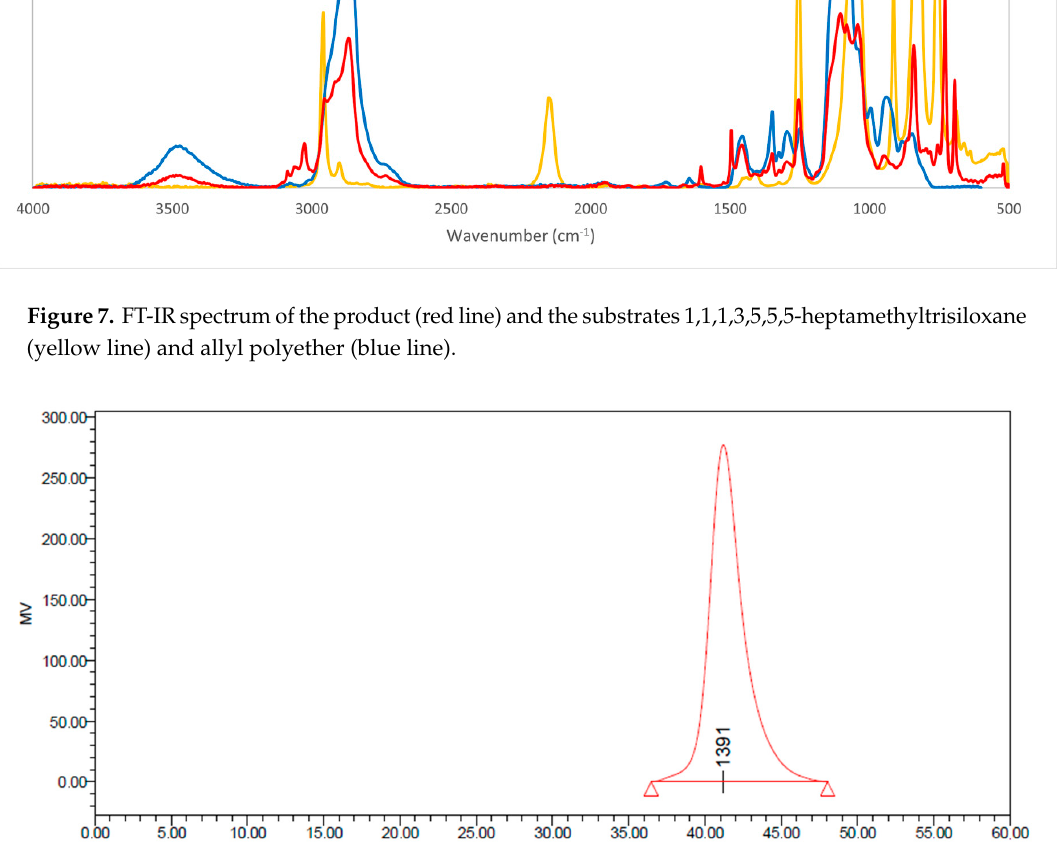
Figure 8. The GPC results of the product.